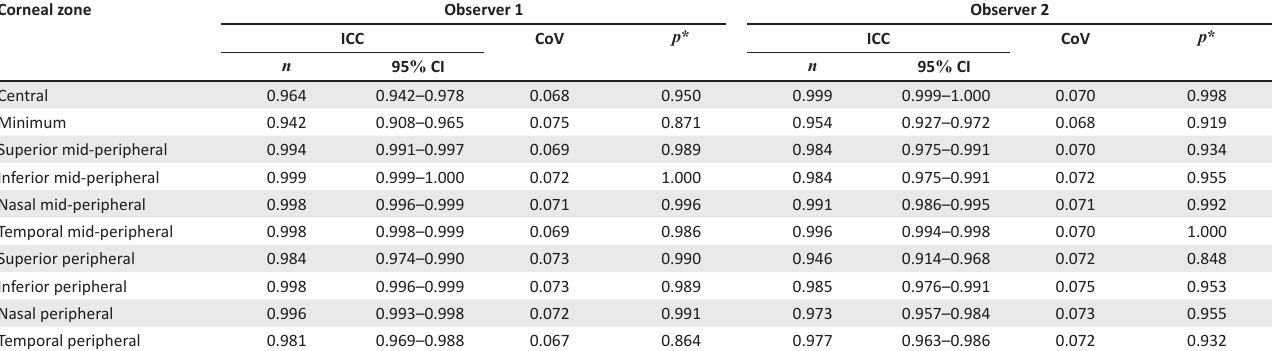
TABLE 1: Intraclass correlation coefficients with confidence intervals, CoV ( % ) and p (ANOVA) for each observer, for corneal thickness measured at the different regions of the right eye. Corneal zone